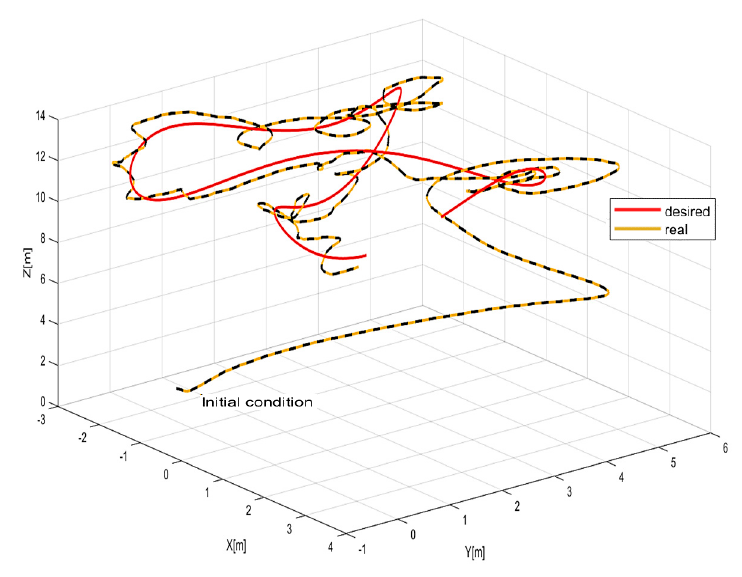
Figure 8. Trajectory tracking: Kinematic controller.